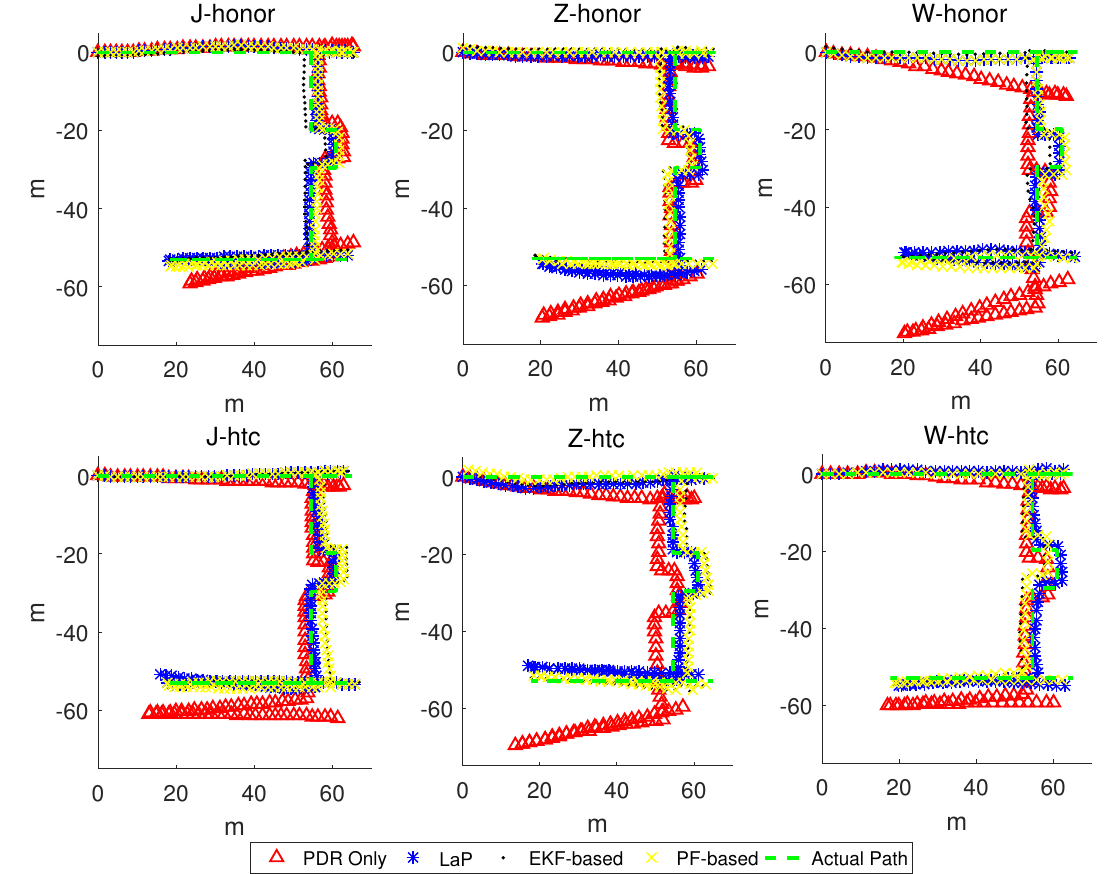
Figure 14. Trajectories of LaP and two other